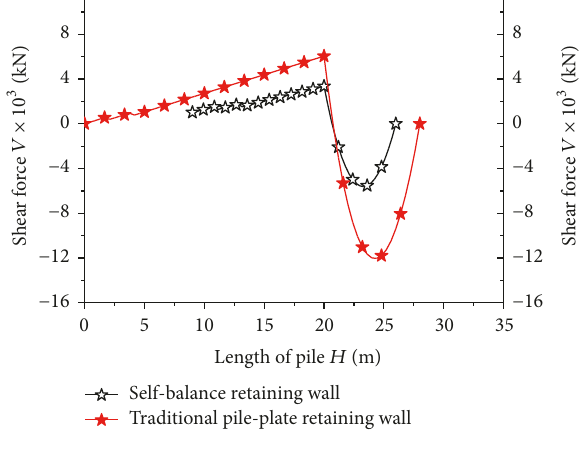
Figure 9: Antislide pile shear diagram.